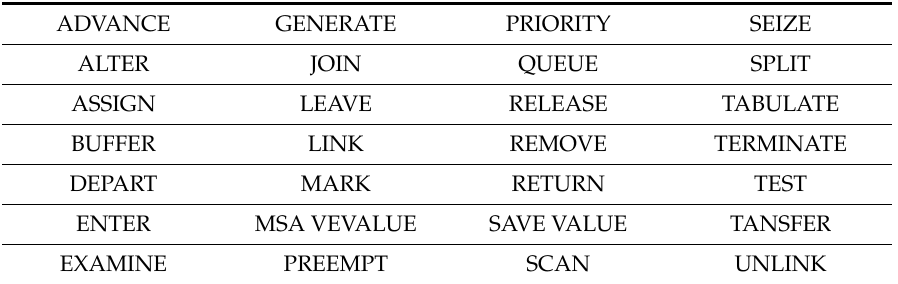
Table 1. The list of blocks supported by the GASP language (Ref. [61]).